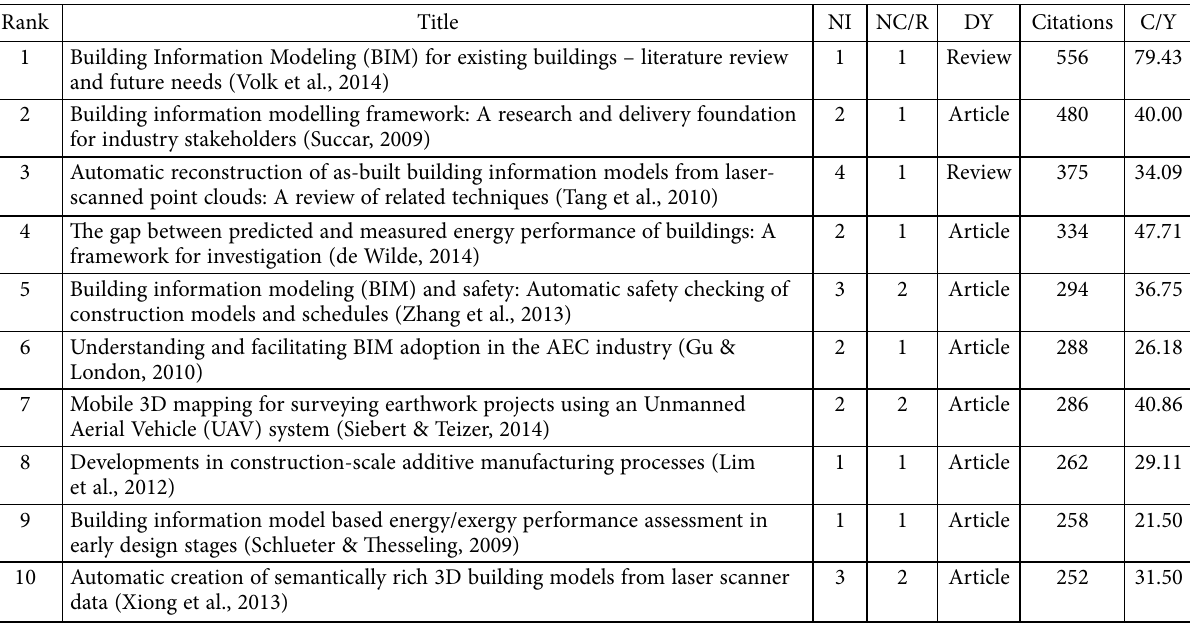
Table 6. The top 10 most cited documents in AutCon according to the